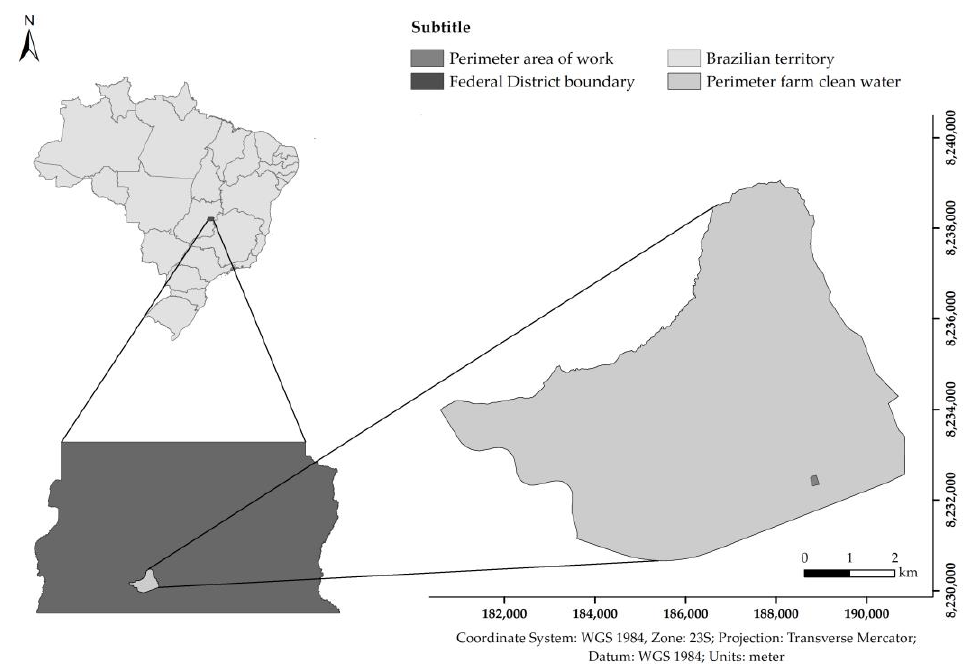
Figure 1. Study area in Fazenda Á gua Limpa, Distrito Federal, Brazil.